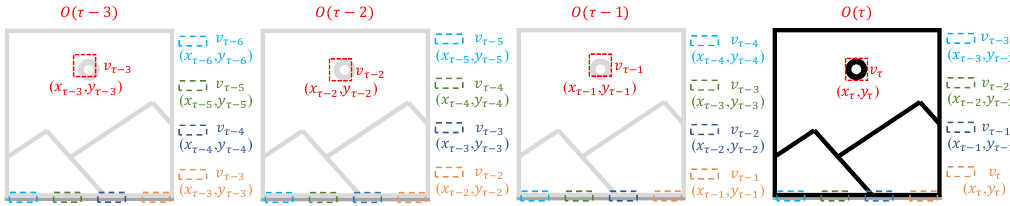
Figure 5. HOG feature storage in adjacent frames for the proposed